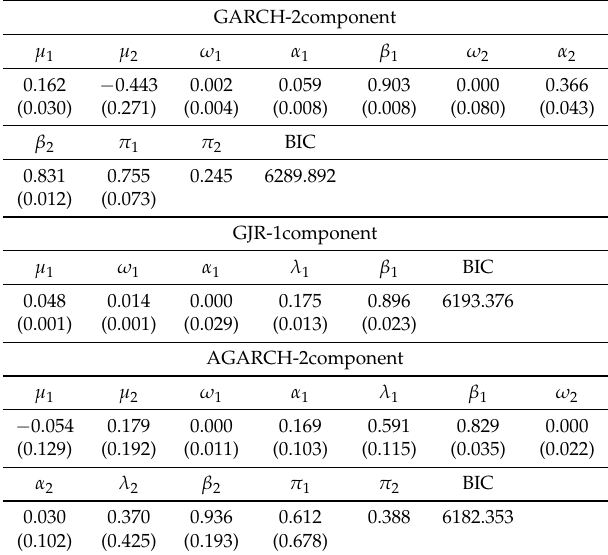
Table 3. Estimation of the Three Classes of GARCH(1,1) Families in the DOW.